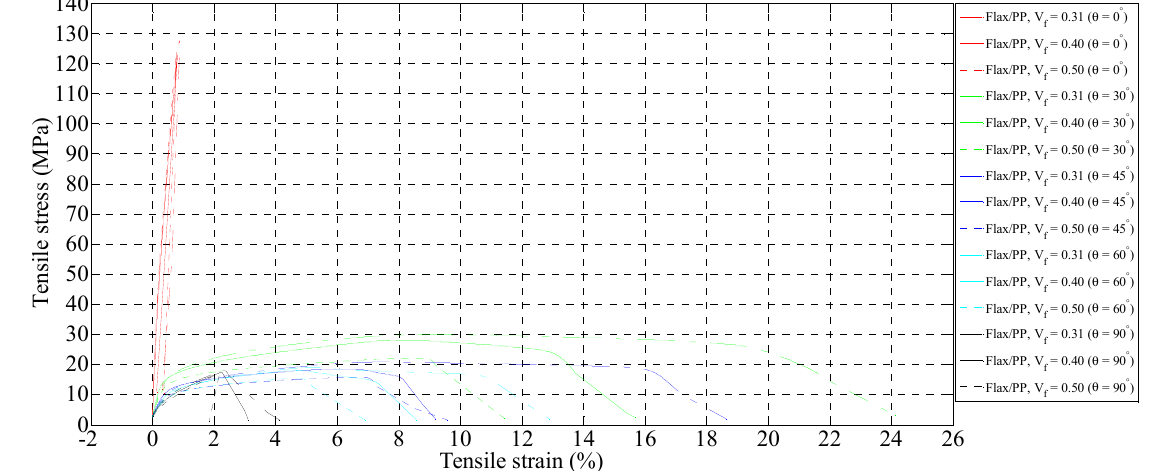
volume fractions and orientations.